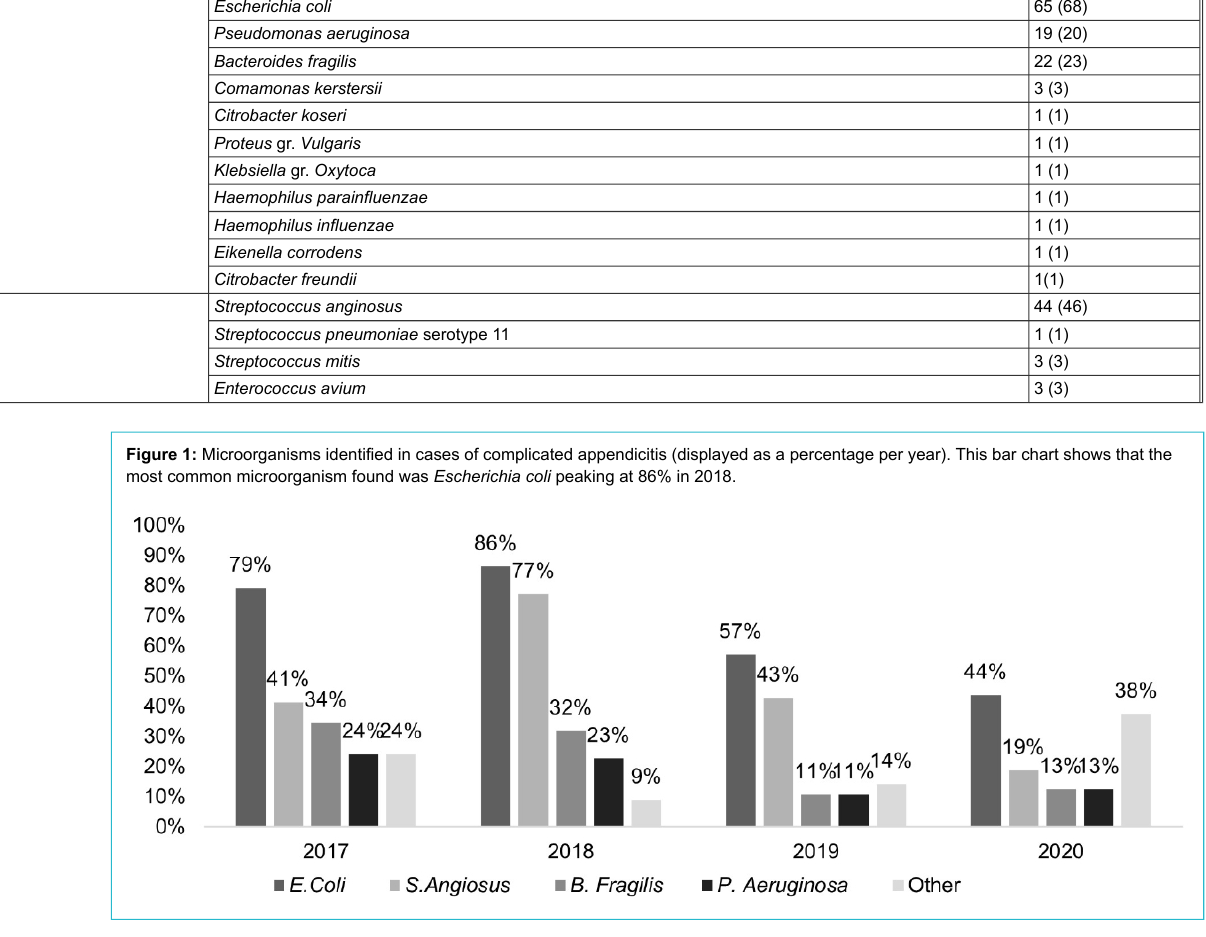
Table 2: Microorganisms identified in peritoneal swab cultures sent for aerobic and anaerobic analysis. Microorganisms